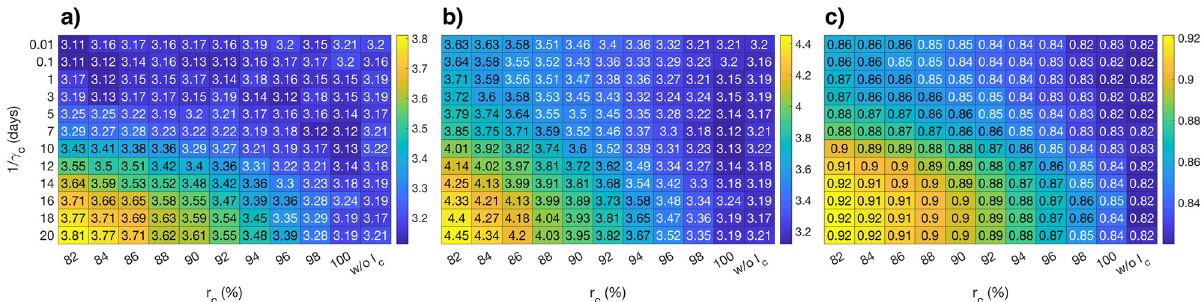
Fig 4. Median of the posterior distributions of parameters. Median values of the posterior distributions of the a) basic reproduction number of the primarily infected population ( R p ), b) total basic reproduction number ( R 0 lockdown (1 − r ), for a given { r , γ } L c c